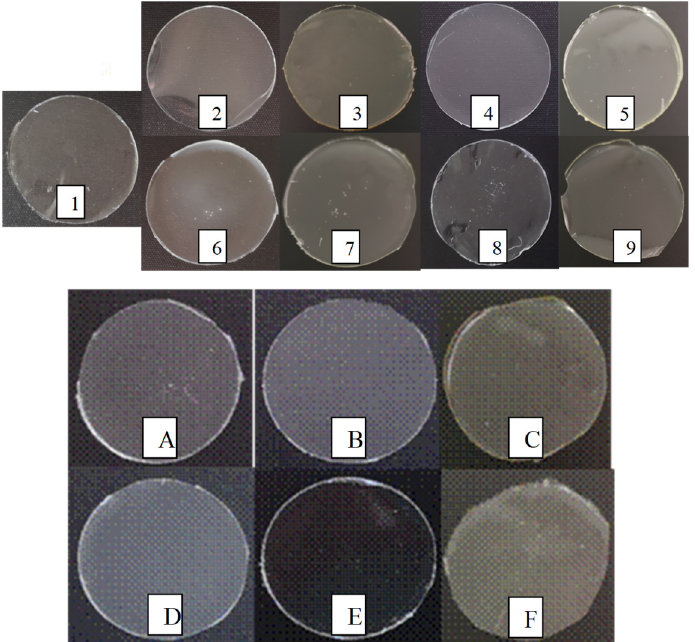
Figure 4. Visual appearance of edible film samples with and without transglutaminase: ( 1 ) CMCH 100 (left); ( 2 ) NaCA 100, ( 3 ) NaCA 75, ( 4 ) NaCA 50, ( 5 ) NaCA 25, ( 6 ); CaCA 100, ( 7 ) CaCA 75, ( 8 ) CaCA 50, ( 9 ) CaCA 25, ( A ) NaCA 75-TGase, ( B ) NaCA 50-TGase, ( C ) NaCA 25-TGase, ( D ) CaCA 75-TGase, ( E ) CaCA 50-TGase, ( F ) CaCA 25-TGase [CHCH = carboxymethyl chitosan; NaCA = so- dium caseinate, CaCA = calcium caseinate, 100, 75, 50, and 25 represent the proportion of the indi- vidual component, the balance out of 100 being CMCH)].